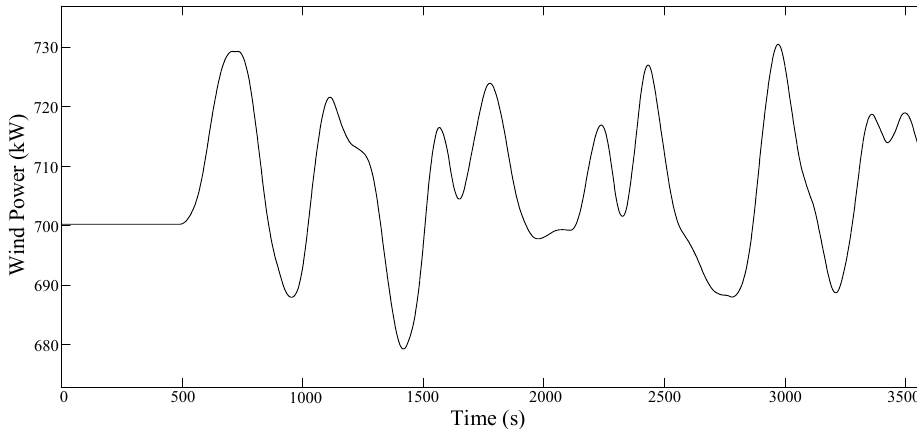
Figure 6. The wind power curve output by a single wind turbine.